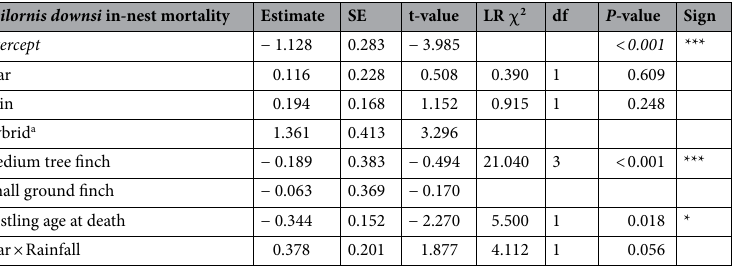
Table 5. Generalized linear model for avian vampire fly ( Philornis downsi ) in-nest mortality in relation to year and rainfall (interaction term) and species, including the co-variate ‘nestling age at death, ranging from 1 to 14 days). Including this co-variate reduces our data set to n = 106. Avian vampire flies collected from Darwin’s finch nests in 10 sampling years over a 17-year period (2000–2020) on Floreana Island. Significant estimates indicated in bold. a Species ‘small tree finch’ was used as a reference category. × indicates an interaction term. Note all quantitative input variables were scaled and centred. Dispersion Parameter for quasibinomial family taken to be 12.273. Intercept presented in italics. Sign = significance levels: ‘***’ < 0.001; ‘*’ <